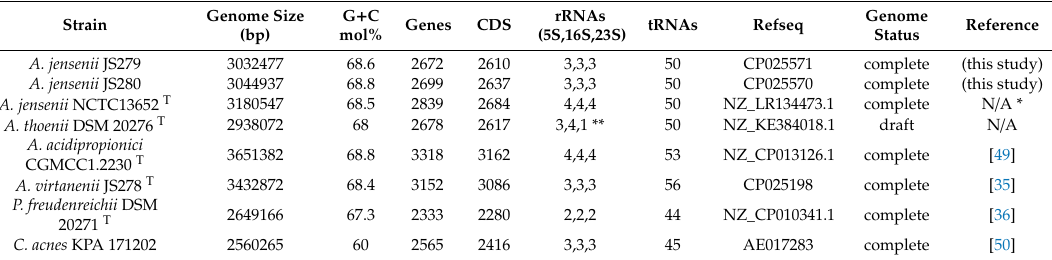
Figure 1. Average nucleotide identities (%) (BLAST-based) between the newly sequenced A. jensenii JS279 and A. jensenii JS280 strains and type strains of the most closely related species for which the genome sequence is available. * Equivalent of the type strain DSM 20535; ** Equivalent of the type strain DSM 4900; *** Not type, but the most studied strain of Cutibacterium acnes ; T indicates type strain of the species. Table 2. Genome summaries of the strains included in ANIb